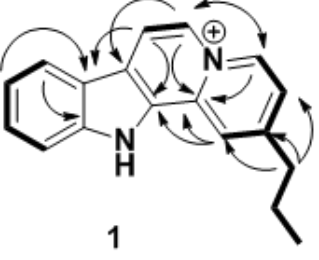
Figure 2. Key COSY (bold) and HMBC (H → C, arrow) correlations for 1